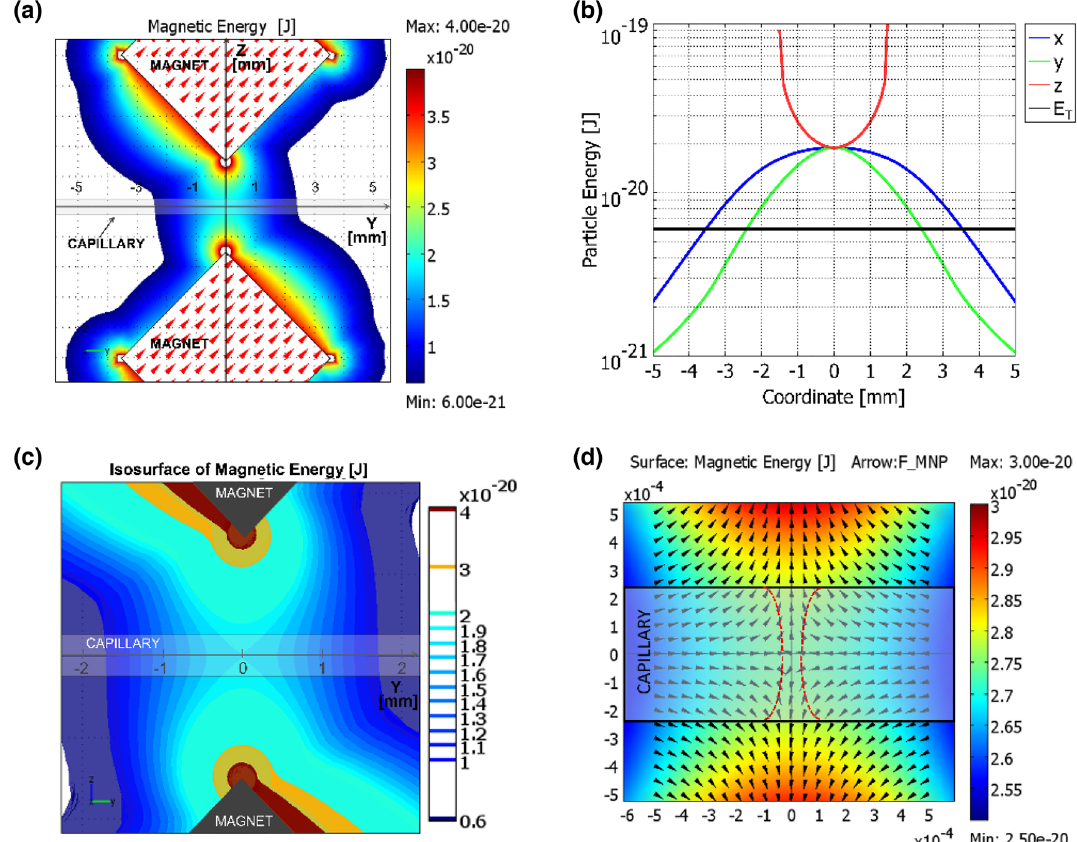
Figure 6. (a) The distribution of the magnetic energy in yz-plane for the experimental set-up (Fig. 2a,b). The color scale depicts the 0.6–4.0 × 10 –20 J energy interval where E m > E T . The red arrows show the directions of magnetization in the magnets. ( b) Magnetic energy distribution along the axes defined in (a) (x-axis orthogonal to the plane of the figure), while the black line represents the thermal energy. ( c ) Zooming of ( a ) with the isosurfaces of magnetic energy between the magnets. ( d ) The further zooming of the working area to compare the magnetic energy maps with the confinement of nanoparticles from Fig. 3a, sketched by two red dashed lines. The black arrows show the direction of the magnetic forces acting on